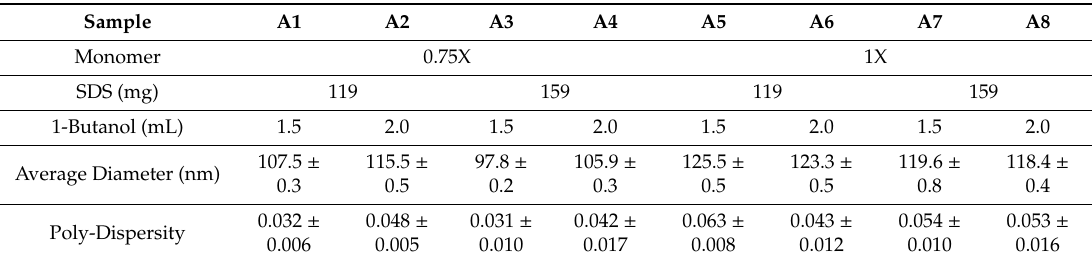
Table 1. Average e ff ective diameter and polydispersity of poly(HEMA) nanoparticles crosslinked with ethylene glycol dimethacrylate (EGDMA). Nanoparticle formulations contained various amounts of organic phase, surfactant, and monomer phase. The error associated with the diameter and polydispersity was obtained from the standard error of minimum triplicate measurements.